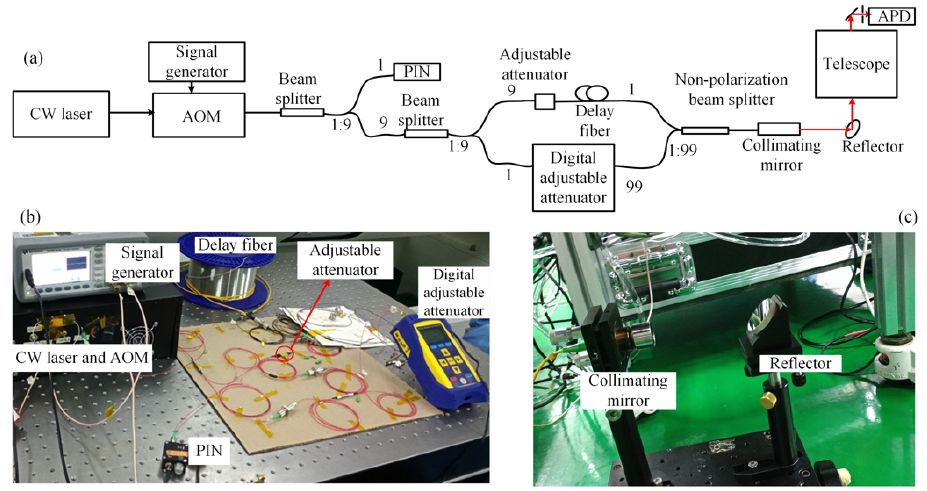
Figure 5. ( a ) Schematic diagram of detector linearity test setup. ( b ) The instruments used for the experiment. ( c ) The instruments used for the experiment.